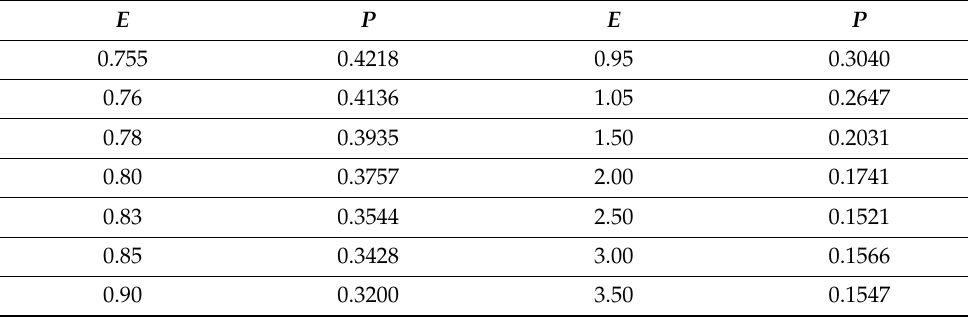
Table 5. Perpendicular cross section.